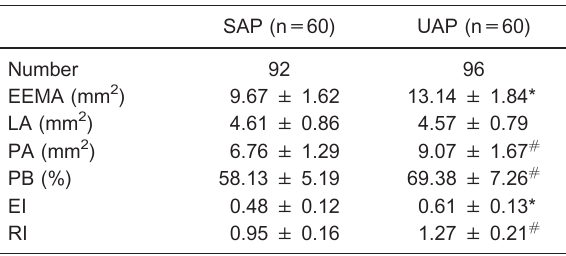
Table 2. Intravascular ultrasound examination results of the stable (SAP) and unstable (UAP) angina pectoris groups of patients.